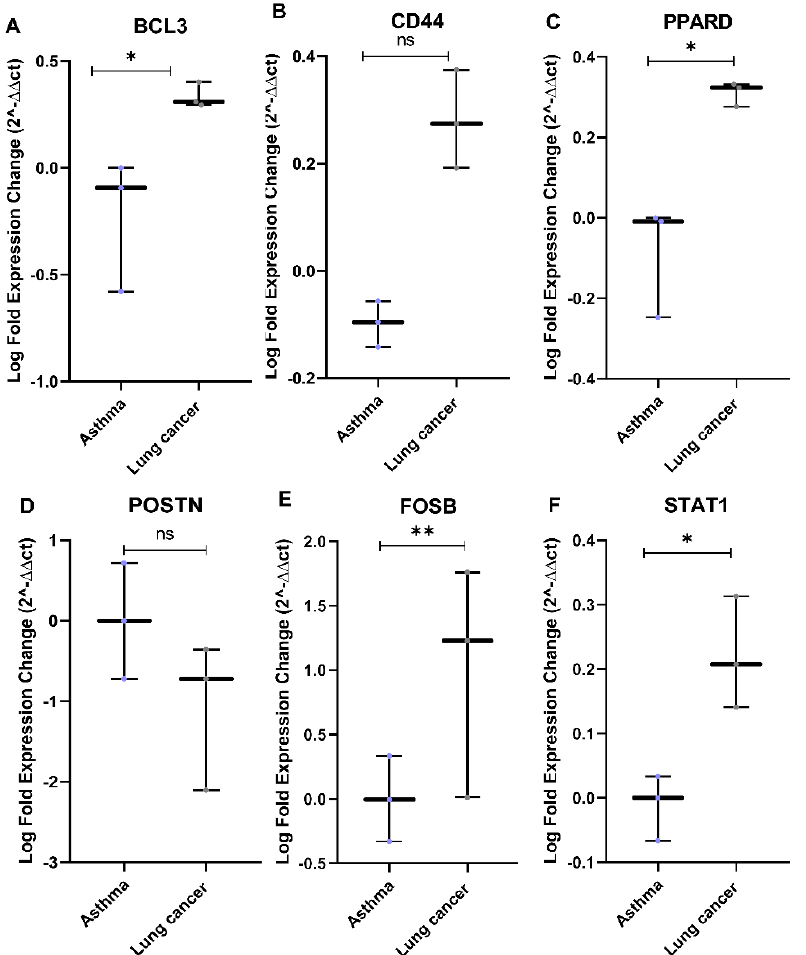
Figure 11. Boxplots for the differential expression of the genes identified in silico in different asthmatic and lung cancer cell lines. ( A ) BCL3 , ( B ) CD44 , ( C ) PPARD , ( D ) POSTN , ( E ) FOSB , and ( F ) STAT1 (Mann − Whitney test, significance * p < 0.05, ** p < 0.01, ns — not significant).